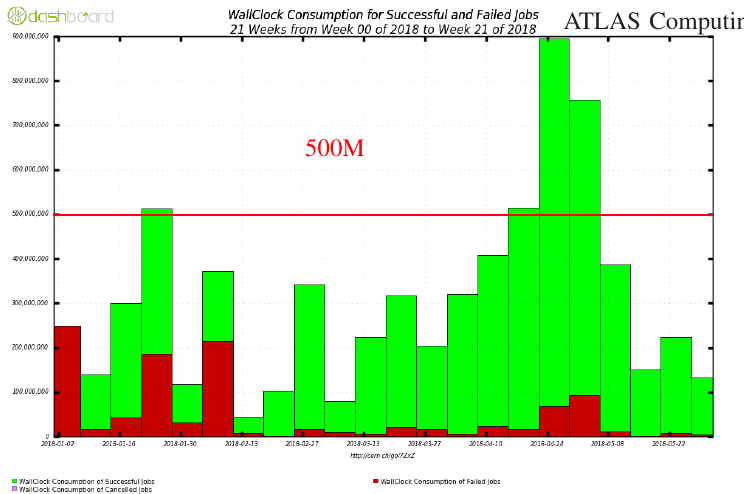
Figure 7. Wallclock consumption in seconds of finished and failed job every week